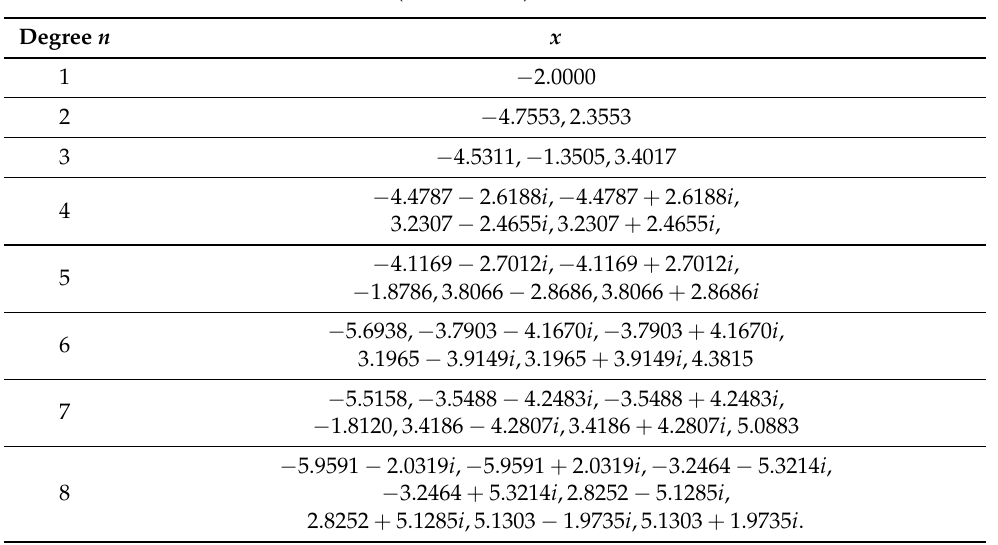
(cid:17) = 0. , 1 2 10